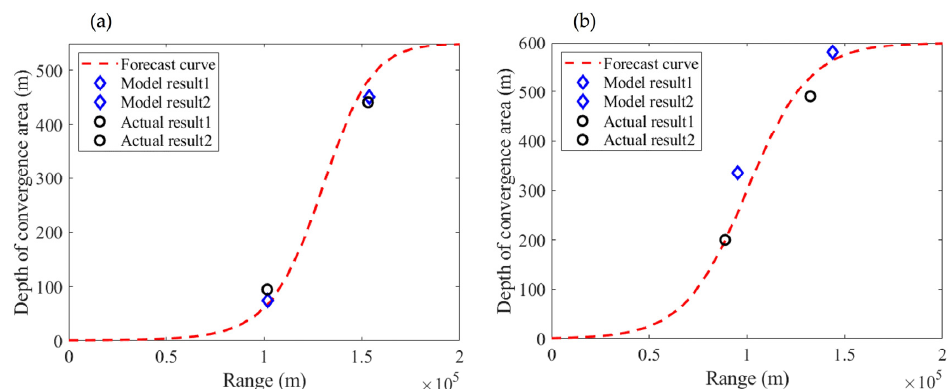
Figure 7. The forecasting curve of the depth of the convergence area (the red dotted line) and the calculating results of the model (blue dots) and actual ocean front (black dots): ( a ) 1 January, representing winter; ( b ) 1 July, representing summer. The forecasting results using the melt function were in good agreement with the model and the actual results, which proved that the melt function was applied to effectively achieve the depth forecast of the convergence area in the ocean front